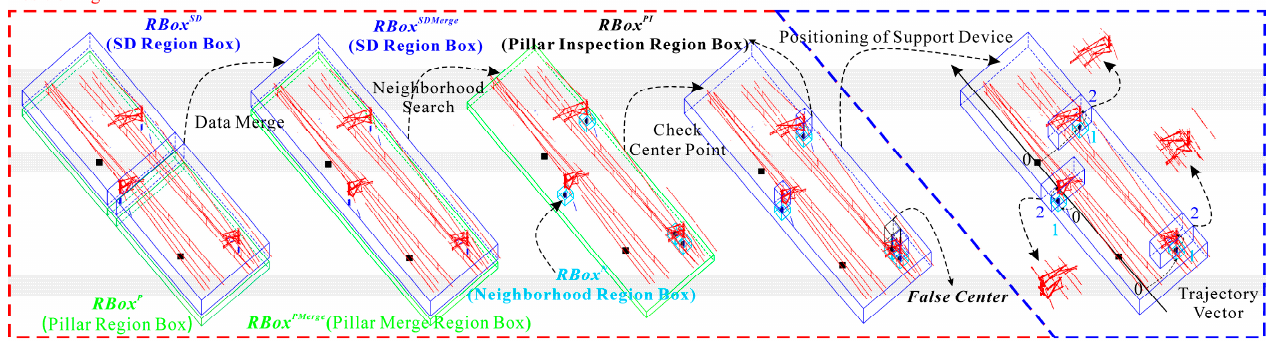
Figure 4. Process flow diagram for the initial extraction of the